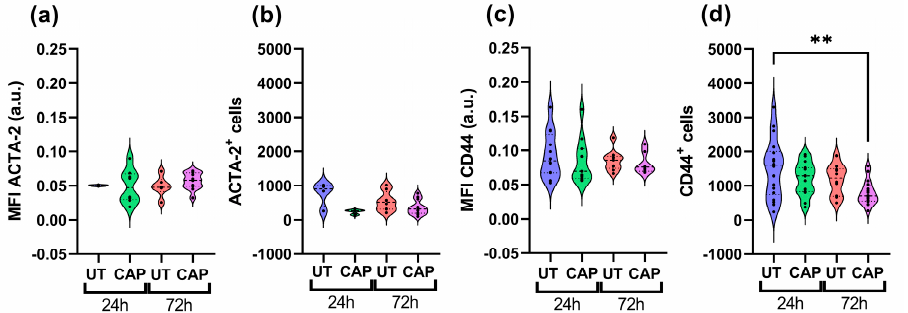
Figure 2. CAP reduces the population of Mia PaCa-2 cells in co-cultured in ovo tissue. Sections were stained for ( a , b ) ACTA-2 (RLT-PSC) and ( c , d ) CD44 (Mia PaCa-2). ( a , c ) Mean fluorescence intensity (MFI) expressed as arbitrary units (a.u.); number of cells positive for ( b ) ACTA-2 or ( d ) CD44. UT = untreated control. n ≥ 4 tissue per condition. Each dot represents one tissue. Dashed lines = median; dotted lines = 25% and 75% quartiles; ** = p ≤ 0.01.